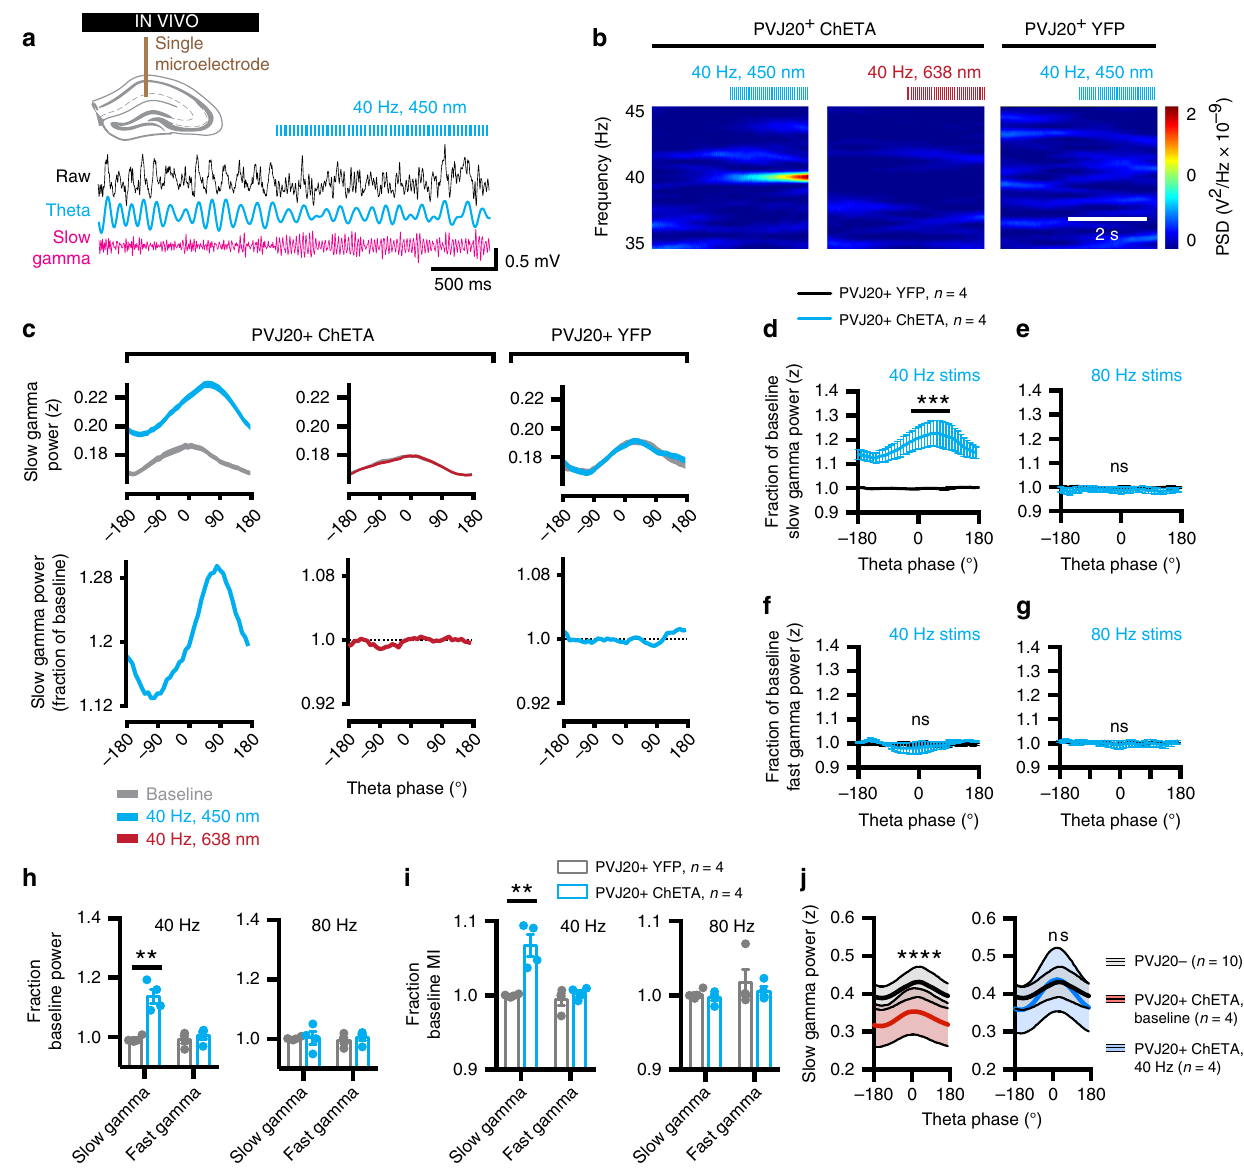
Fig. 3 In 40 Hz stimulations of medial septum parvalbumin neurons increase slow gamma power and coupling to theta oscillations. a Recording con fi guration and representative example of CA1-LFP before and during 40 Hz stimulation at 450 nm. Raw LFP (black), theta band fi ltered trace (blue), and gamma band fi ltered trace (pink). b Representative example Fourier spectrograms of CA1-LFP before and during either 40 Hz, 450 nm stimulation in one PVJ20 + mouse transfected with ChETA (left), or 40 Hz, 638 nm stimulations in the same mouse (center), or 40 Hz, 450 nm stimulation in a different PVJ20 + mouse transfected with a control, YFP construct (right). c 40 Hz stimulation at 450 nm increase gamma power in ChETA transfected PVJ20 + mice (left; 2ANOVA, F (1, 72960) = 5393, P < 0.0001 for the main effect of stimulation, n = 913 stimulation) but not in a PVJ20 + YFP control (right; n = 1689 stimulation) or when using 638 nm laser stimulation (center; n = 918 stimulations). Data is expressed in z scored gamma power (top) or stim/ baseline ratio (bottom), thickness of lines represents SEM. d , e Group averages of stim/baseline slow gamma power ratio. f , g Group averages of stim/ baseline fast gamma power ratio. h Group averages of stim/baseline slow and fast gamma power for 40 and 80 Hz. i Same for modulation index (MI). j Slow gamma amplitude coupling to theta phase before (left) or during (right) 40 Hz optogenetic stimulation. n = 4 PVJ20 + , ChETA mice and n = 4 PVJ20 + , YFP mice were used in d – j . Color codes in b : blue, low power; red, high power. Data expressed as mean ± SEM. ns, not signi fi cant. **, p < 0.01; ***, p < 0.001; ****, p < 0.0001. Test used in d – j 2ANOVA, Sidak ’ s multiple comparison post hoc test. Source data are provided as a Source Data fi